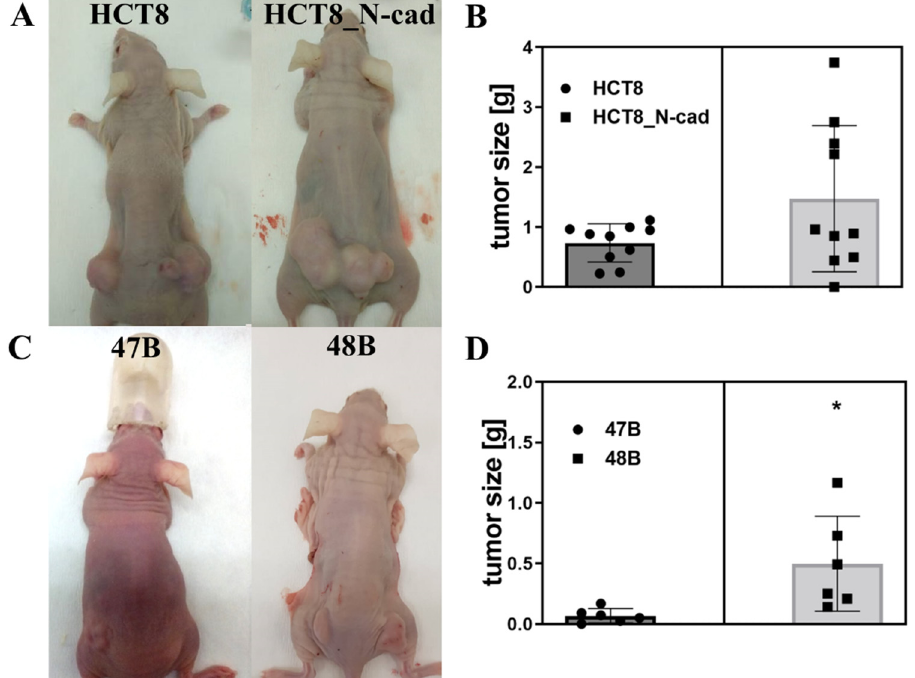
Figure 3. Comparison of tumor growth in Foxn1-nu mice after implantation of colon cancer cell lines and derived primocultures with different levels of N-cadherin. ( A ) mice, 21 days after implantation of HCT8, resp. its N-cadherin plasmid-treated variant; ( B ) comparison of tumor size 21 days after implantation of HCT8, resp. its N-cadherin plasmid-treated variant (n = 10/set); ( C ) mice, 40 days after implantation of derived colon cancer primoculture cells 47B and 48B; ( D ) comparison of tumor size, 40 days after implantation of derived colon cancer primoculturec cells 47B and 48B (n = 6/set). The data present means of ten tumor weight obtained from five mice per tested group in HCT8, resp. six tumor weight obtained from three mice per tested group in 47B or 48B, and their 95% confidence interval values are shown as mean ± SD. * p < 0.05 48B vs. 47B tumor size.